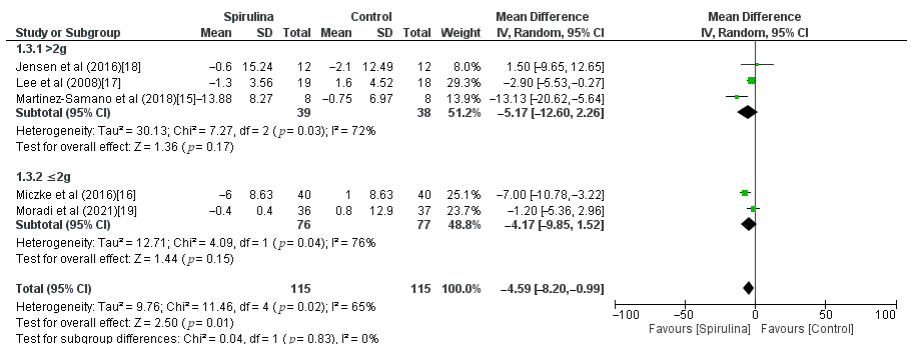
Figure 4. Effect of Spirulina supplementation on systolic blood pressure (SBP) compared with the control group stratified by Spirulina dosage [15–19].